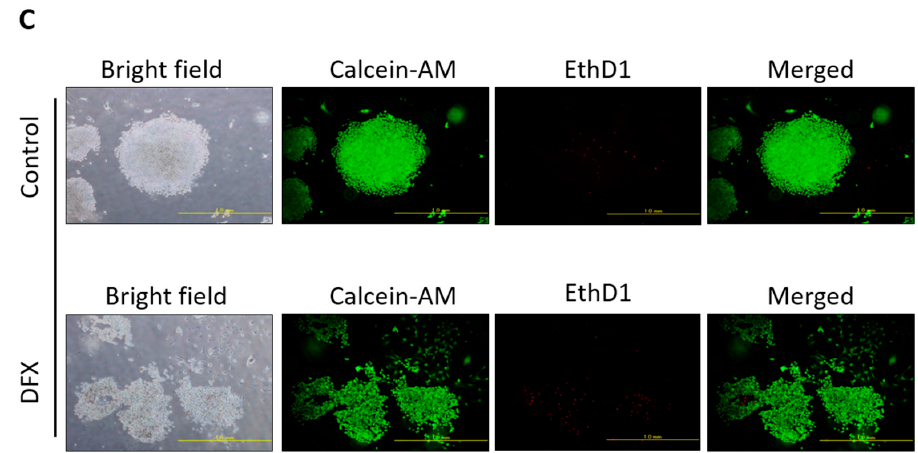
Figure 1. The effect of DFX against stemness of miPS cells in vitro and cytotoxicity analysis. ( A ) miPS cells were treated with the indicated dose of DFX (0, 1, 10, 50, 100 μ M) and subjected to western blot analysis with antibodies to stemness markers (Nanog, Sox2, Oct3/4, Klf4, c-Myc) or β -actin (loading control). Stemness markers were suppressed by DFX at concentrations over 50 μ M. ( B ) miPS cells treated with 50 μ M DFX were cultured in suspension for 72 h. DFX treatment of miPS cells suppressed spherogenesis and GFP expression, which indicates suppression of Nanog. ( C ) Micrographs of the fluorescence-based Live/Dead assay showing live and dead miPS cells following treatment with 0.2% DMSO (control) or 50 μ M DFX (magnification ×40). The morphology of miPS cells after treatment with DFX changed from round to spindle shaped. Almost all cells were stained green, which indicates live cells.